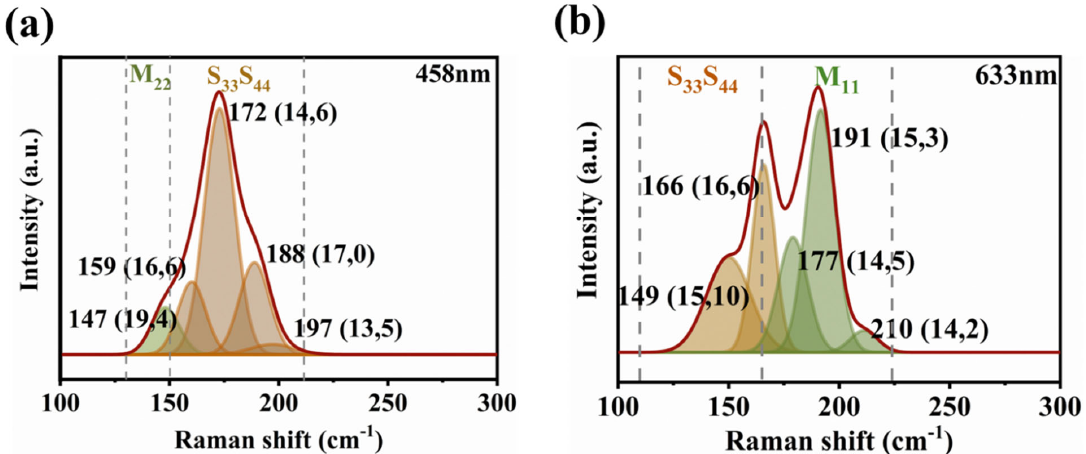
Figure 7. Raman spectra of the BA–PMS dispersed SWNTs at the excitations of ( a ) 458 and ( b ) 633 nm, respectively, in the range of 100 – 300 cm − 1 .